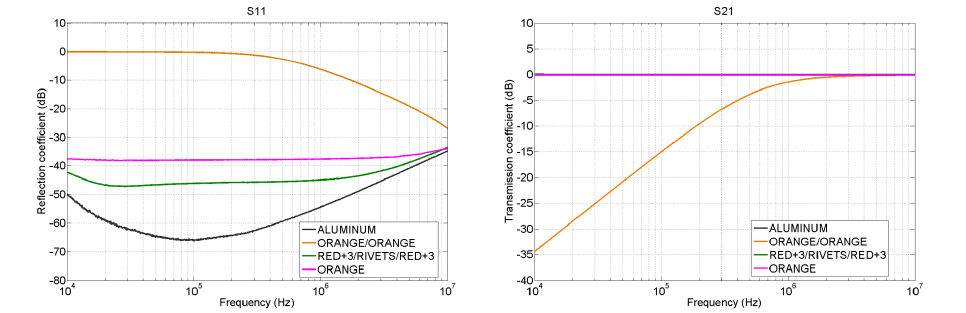
Figure 17. Microstrip S-parameter measurement: S 11 ( left ) and S 21 ( right ).